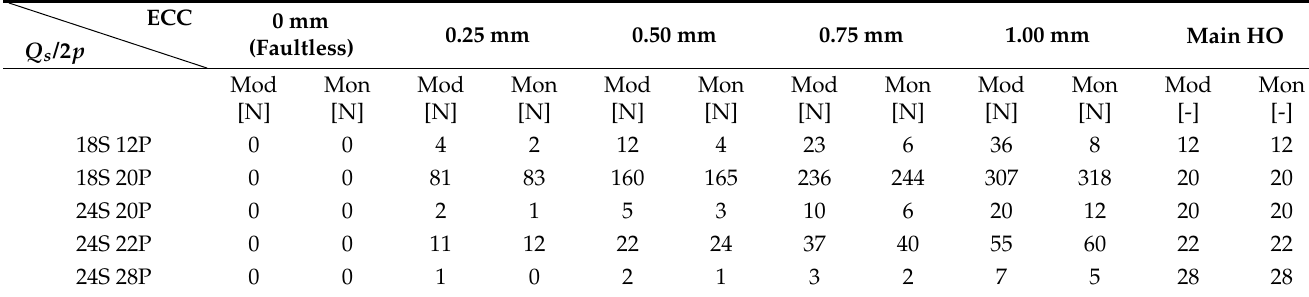
Table 8. Radial force ripple for different slot/pole combinations of PMSM and MPMSM in the presence of